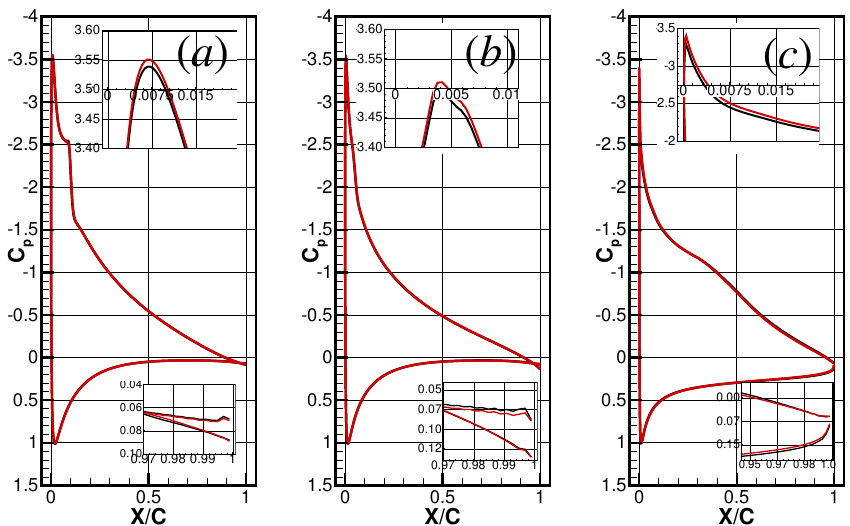
Figure 6. LES averaged pressure coefficients. ( a ): NACA 0015, Re L = 180,000, α = 10 ◦ ; ( b ): NACA 0012, Re L = 300,000, α = 8 ◦ ; ( c ): EPPLER 387, Re L = 300,000, α = 7 ◦ .